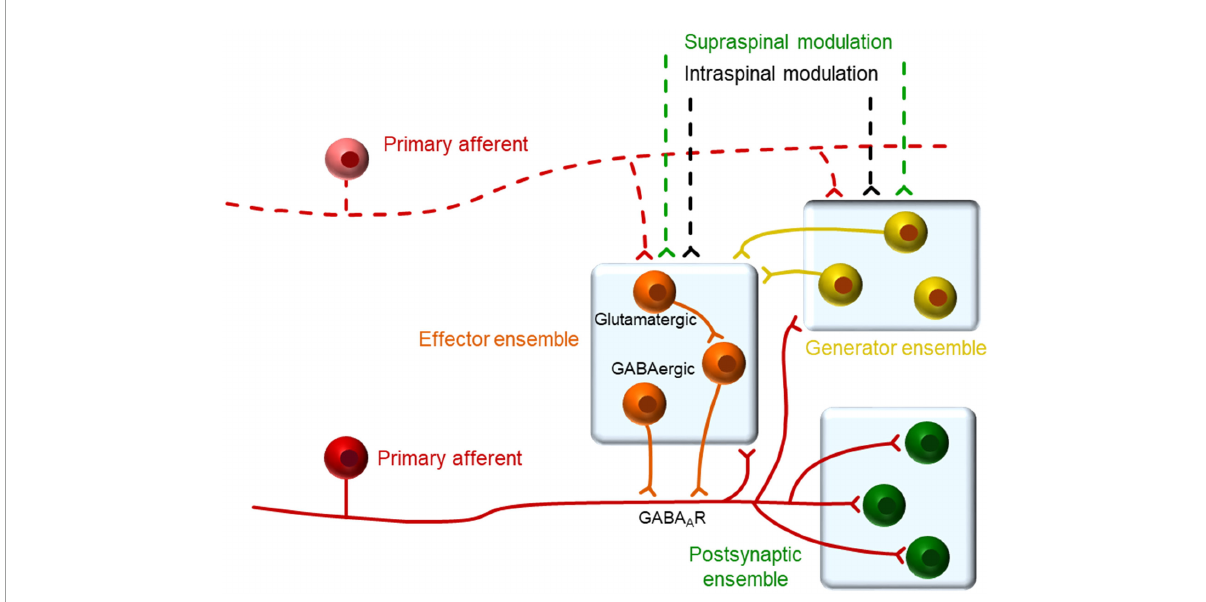
FIGURE7 Proposed organization of neurons in relation to primary afferents. We propose that dorsal horn neurons within a single segment may belong to one of three functional types as defined by their relation to the primary afferents. A generator ensemble, formed by spontaneously active neurons, which provide synaptic input to other neurons maintaining the excitability of the system. An effector ensemble formed by neurons in close apposition to the afferent responsible for the actual generation of PAD. A third set of neurons that are excited by the afferent and form a heterogeneous group including projection neurons and interneurons that may belong to the previous ensembles. The activity of this system may be modulated by spinal and supraspinal inputs in the behaving